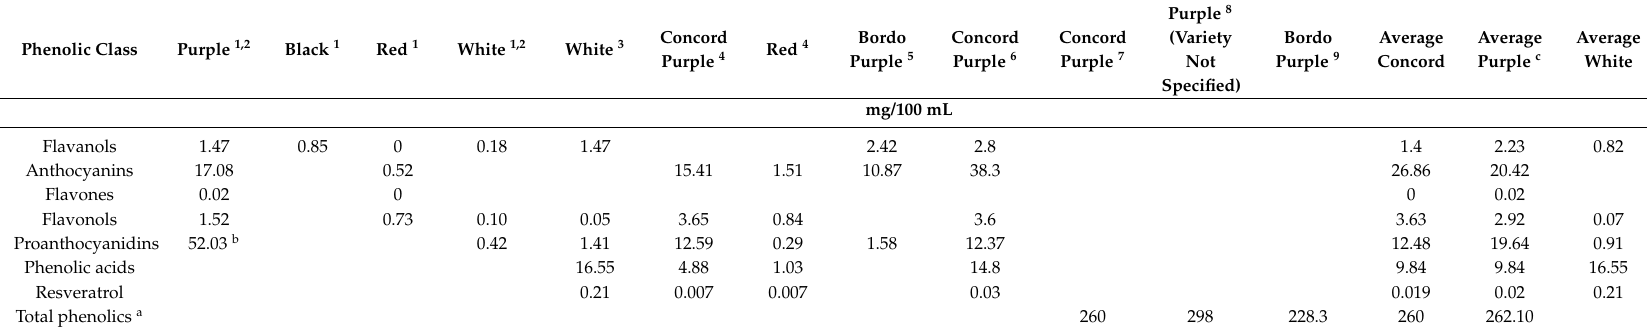
Table 1. Phenolic Compounds in Grape Varieties